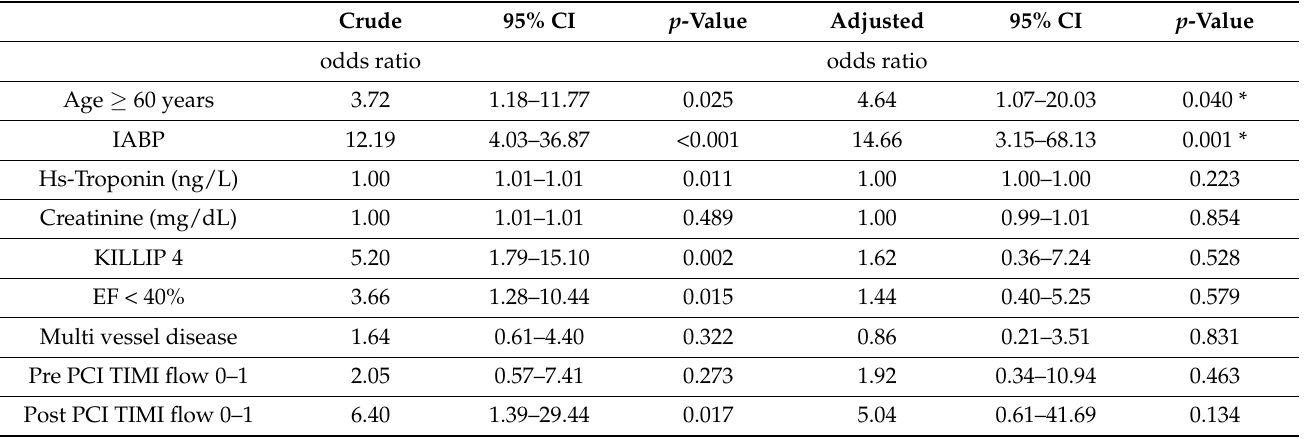
Table 2. Multivariable analysis for in-hospital mortality of STEMI patients during the COVID-19 outbreak.